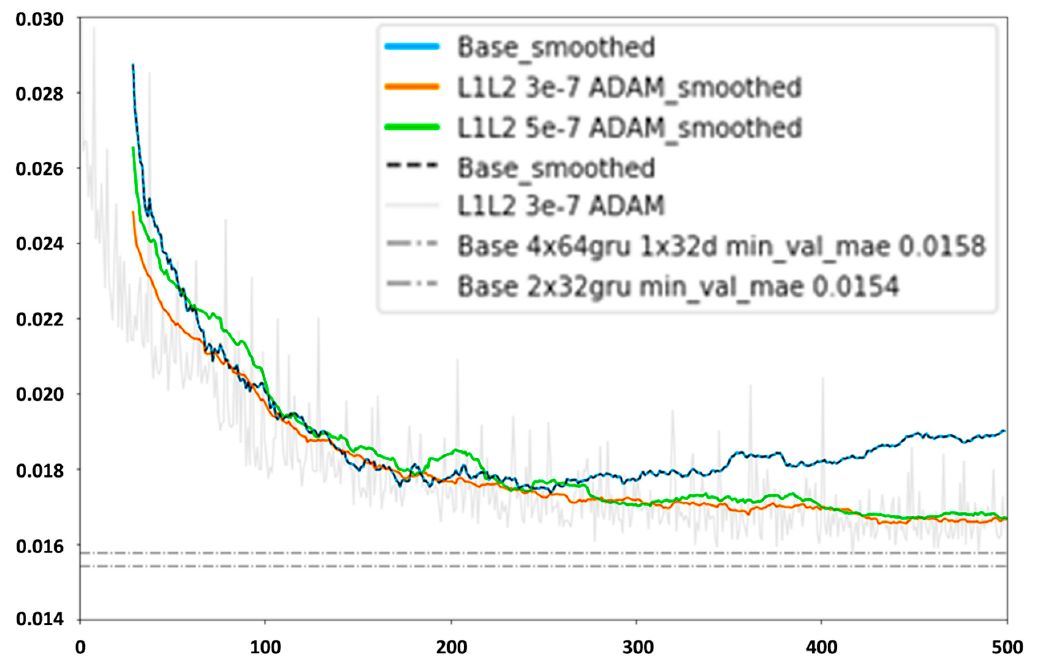
Figure 13. Second deepest model (4 × 64 GRU, 1 × 32 FF) with weights regularization. Table 5. Summary of results (energy consumption data range is ~40–170; * performance of best recurrent neural networks model).